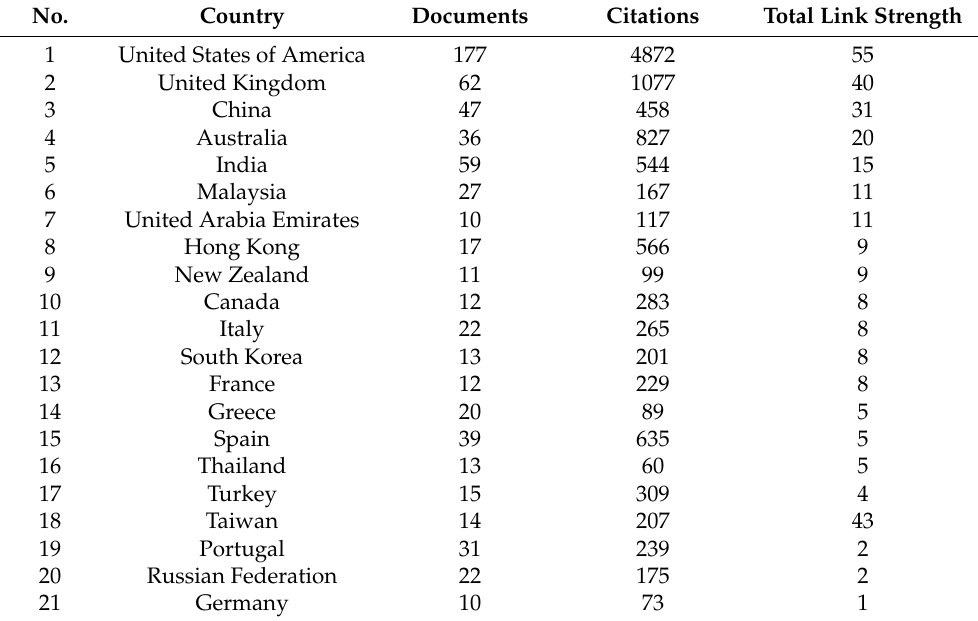
Table 7. Top countries by co-authorship productivity in organizational